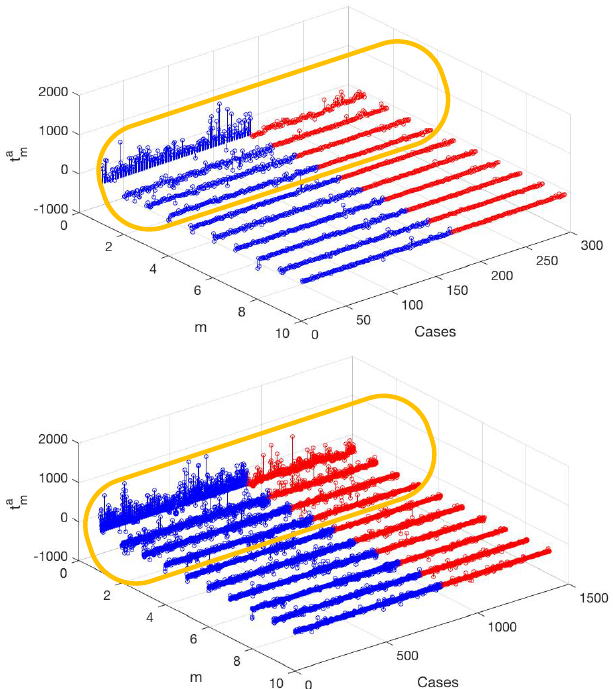
Figure 5. Representation of the weights given by the projection of each force signal case on the first 10 eigenvectors, for the contact (blue) and non-contact (red) cases, for a = 10, in the high-confidence ( up ) groups and on the complete database ( down ). The oval emphasizes that the differences are more visually patent on the first four weights, in such a way that larger variance can be observed on them. Nevertheless, the other components also exhibit statistical differences, which can be less present to the naked eye, but can be exploited from statistical data processing